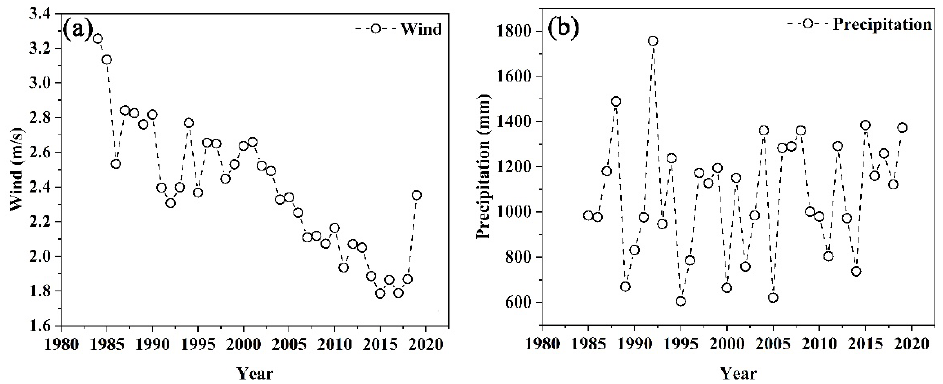
Figure 9. ( a ) Wind speed changes from 1984 to 2019; ( b ) precipitation changes from 1984 to